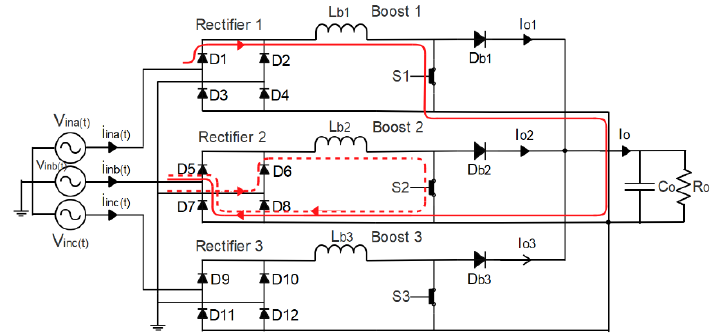
Figure 3. First interaction of current traveled in phase a.